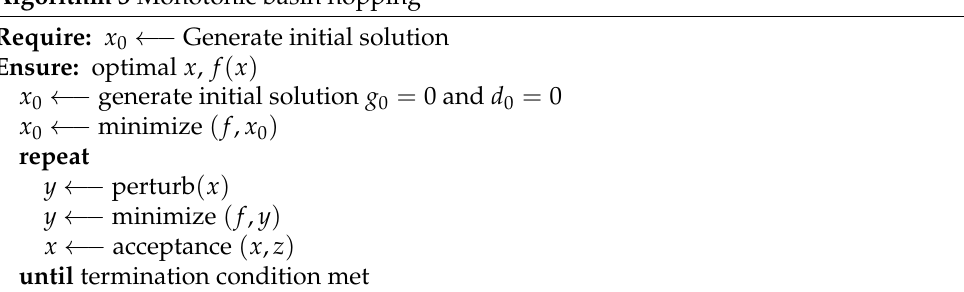
Algorithm 3 Monotonic basin